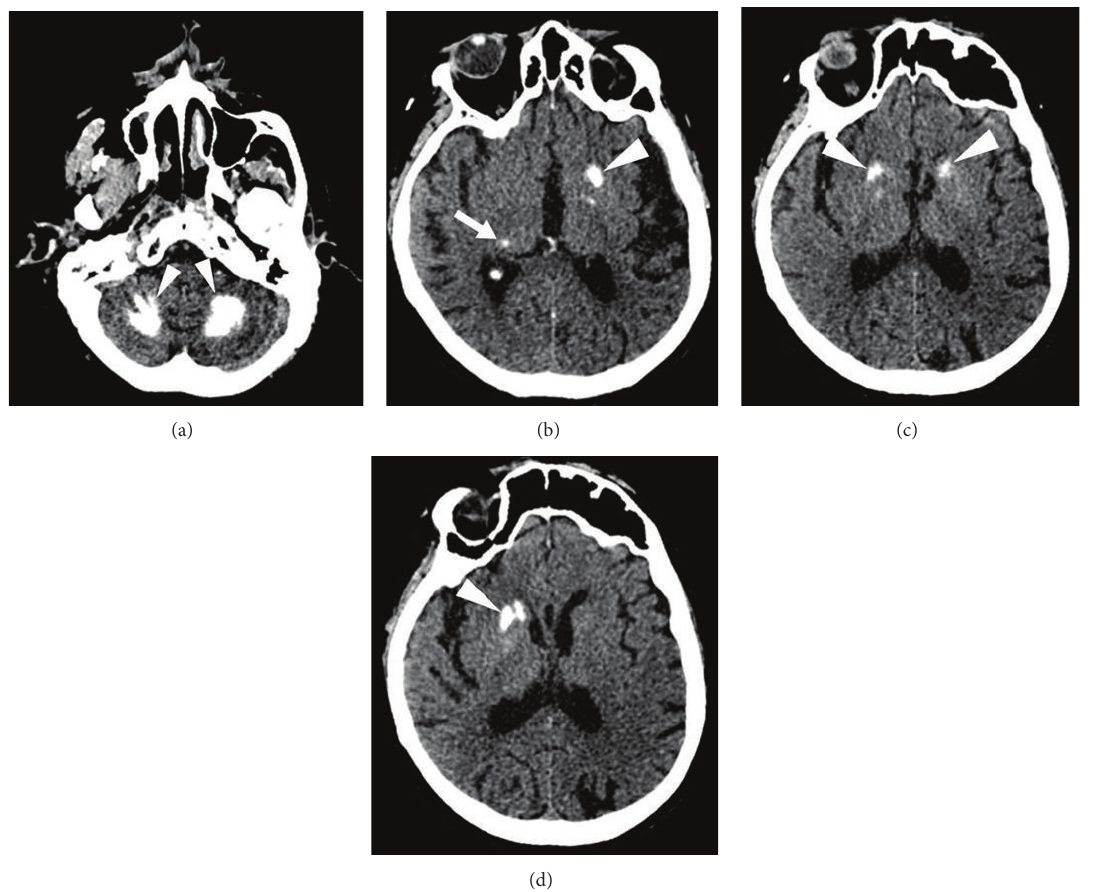
Figure 8: A patient with vitamin D deficiency with extensive cerebellar (a) and basal ganglia (arrowheads on b, c, and d) and thalamic (arrow on b) calcifications on CT.